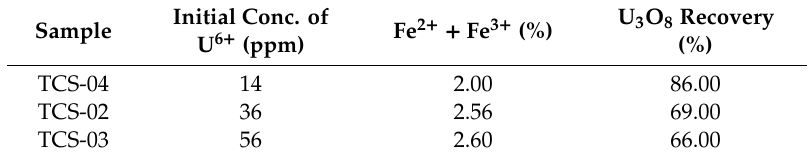
Table 10. Initial U 6 + concentration in rock samples and uranium recovery in nearly neutral media.